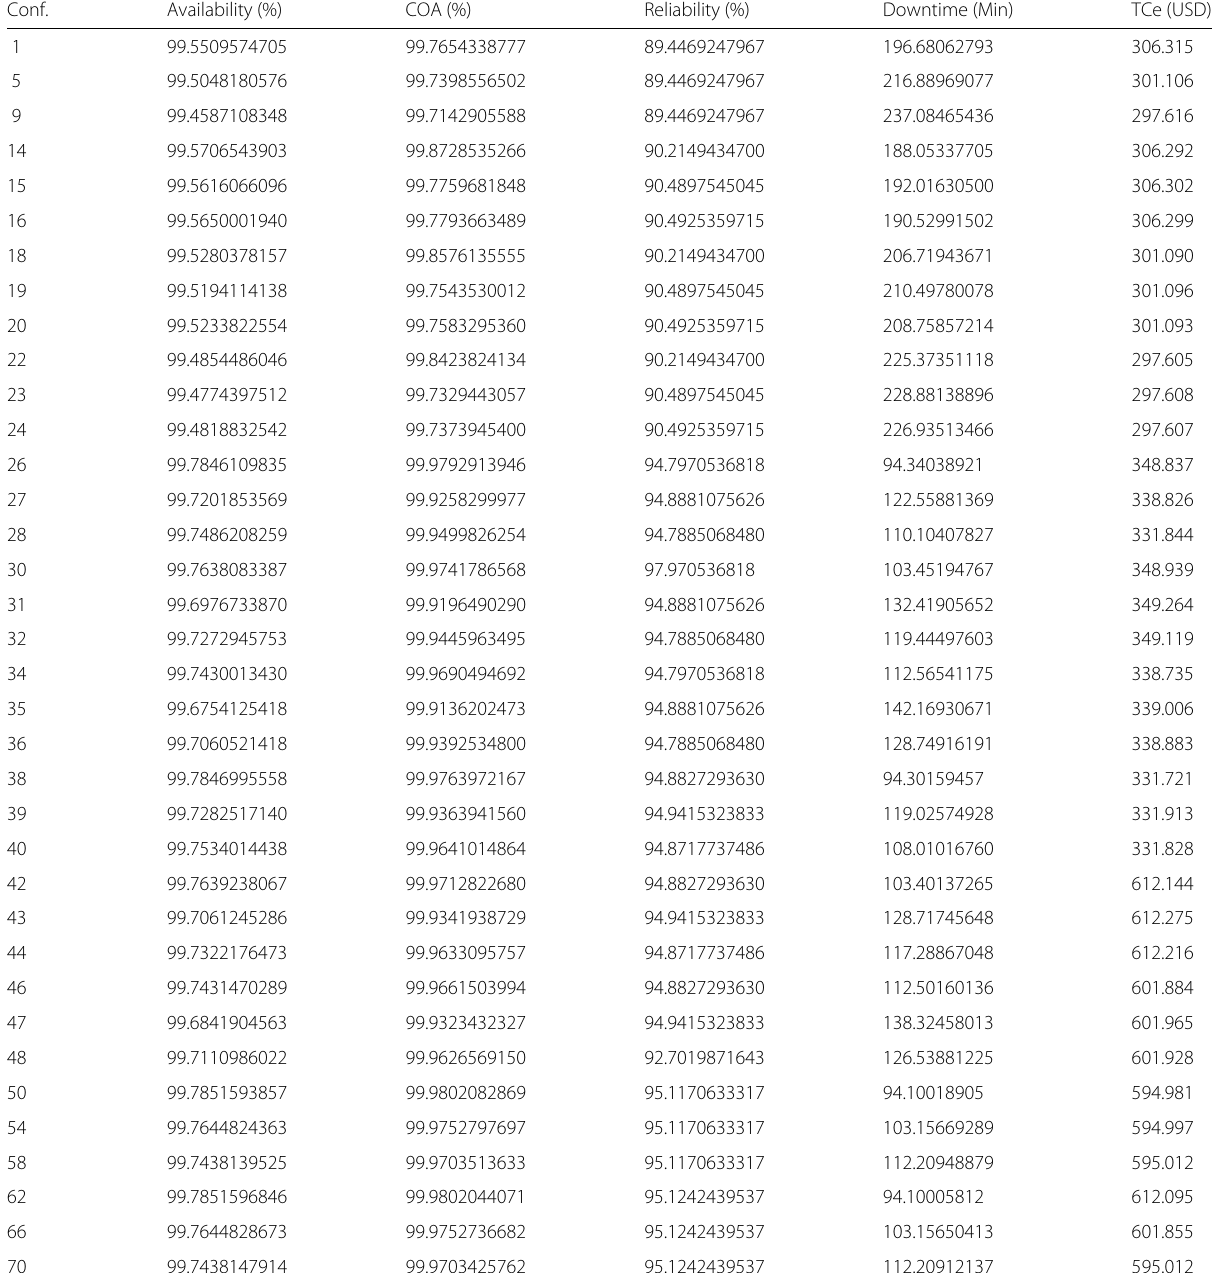
Table 9 Dependability and cost results for each configuration